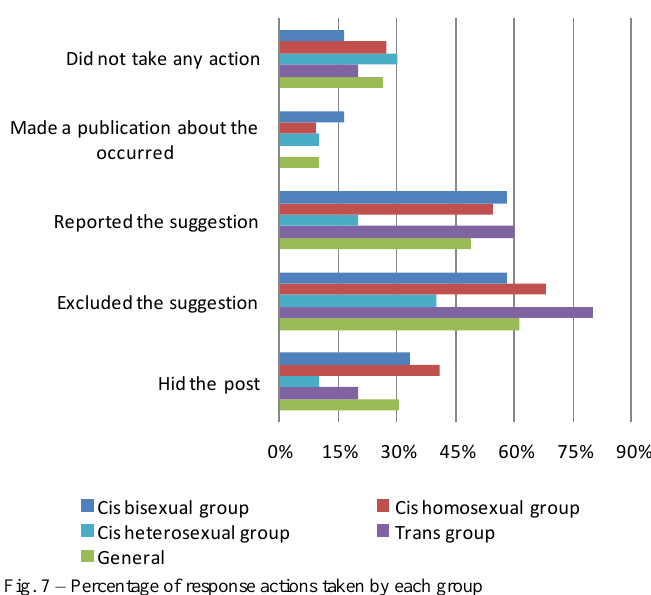
Fig. 6 – Percentage of content type signalized by each group